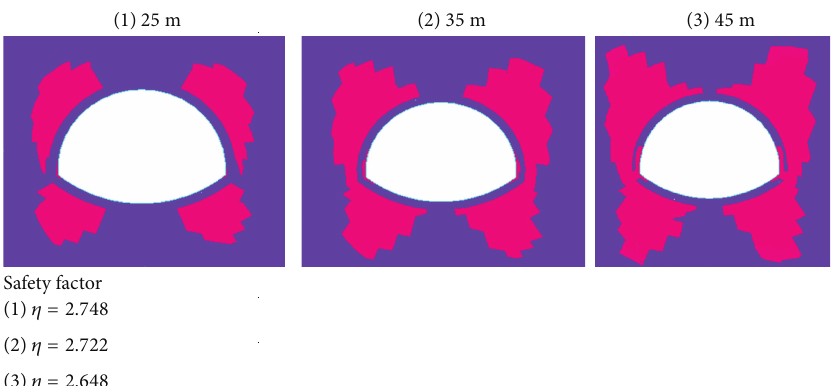
Figure 6: Plastic zones and safety factors with different thicknesses of the overburdens.